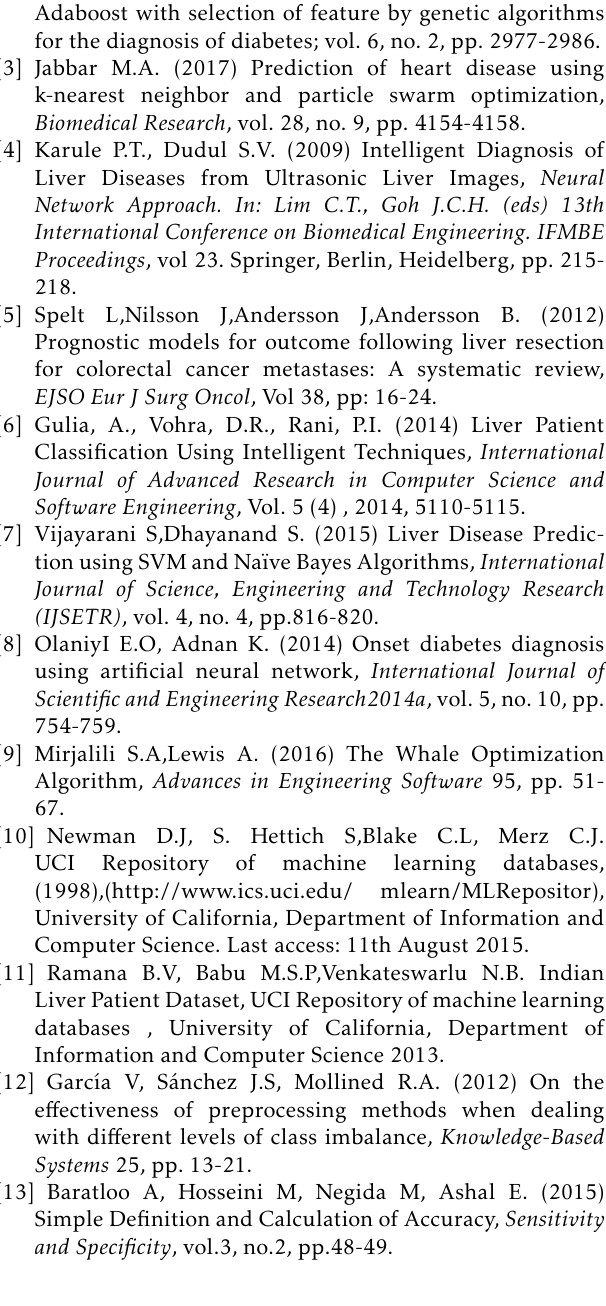
algorithm based on K-nearest-neighbor algorithm